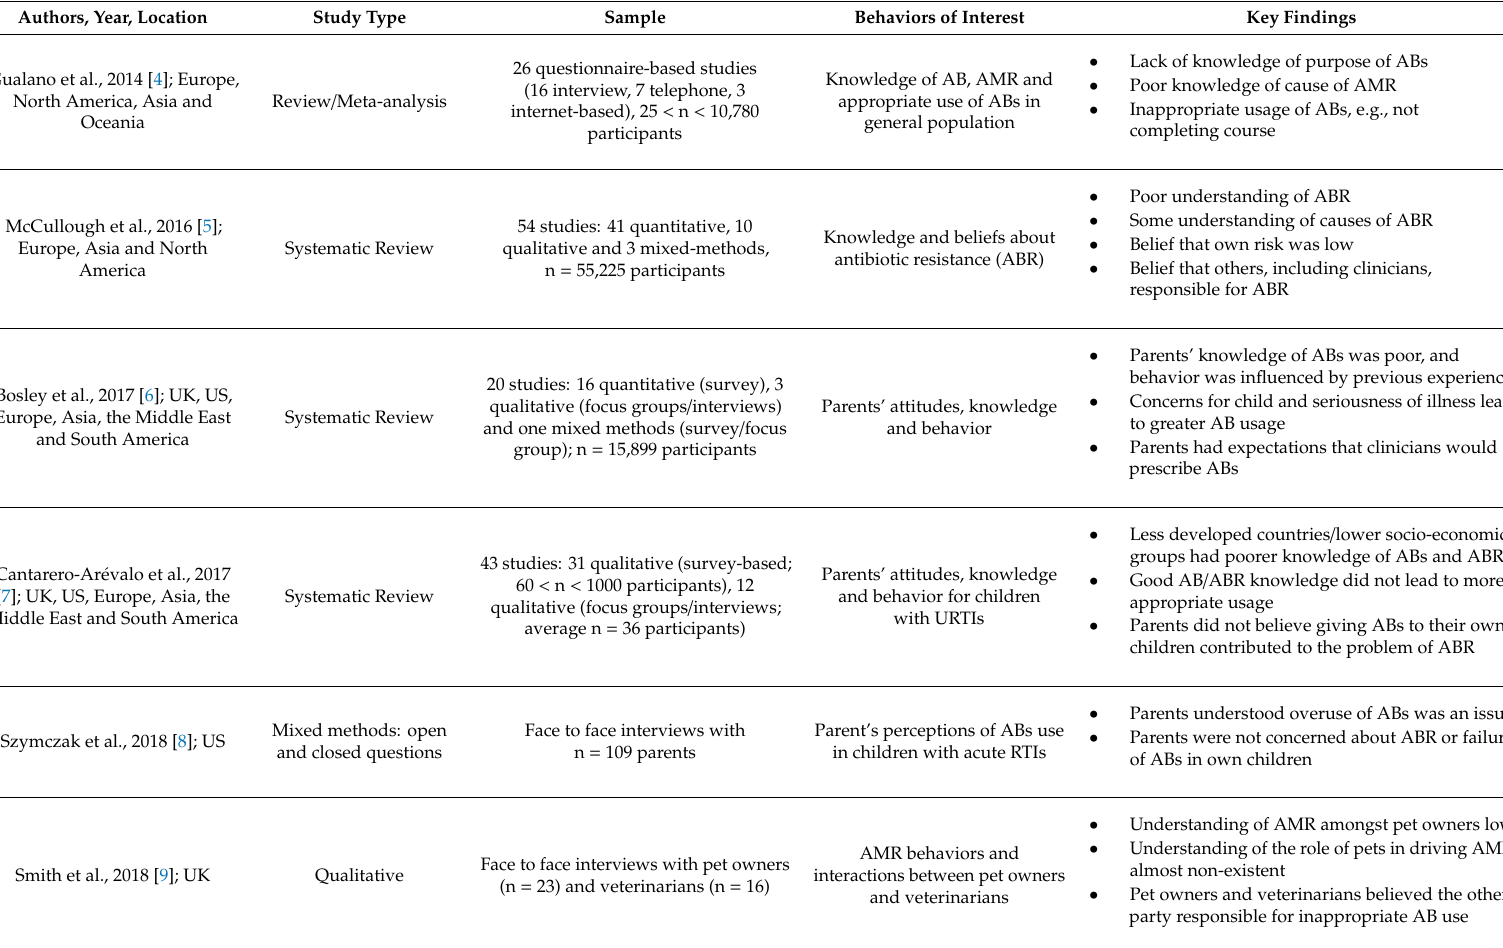
Table 1. Reviewed studies of psychological determinants of antibiotic (AB) / antimicrobial (AM) usage and AB / AM resistance (ABR) / (AMR) in humans. Authors, Year,